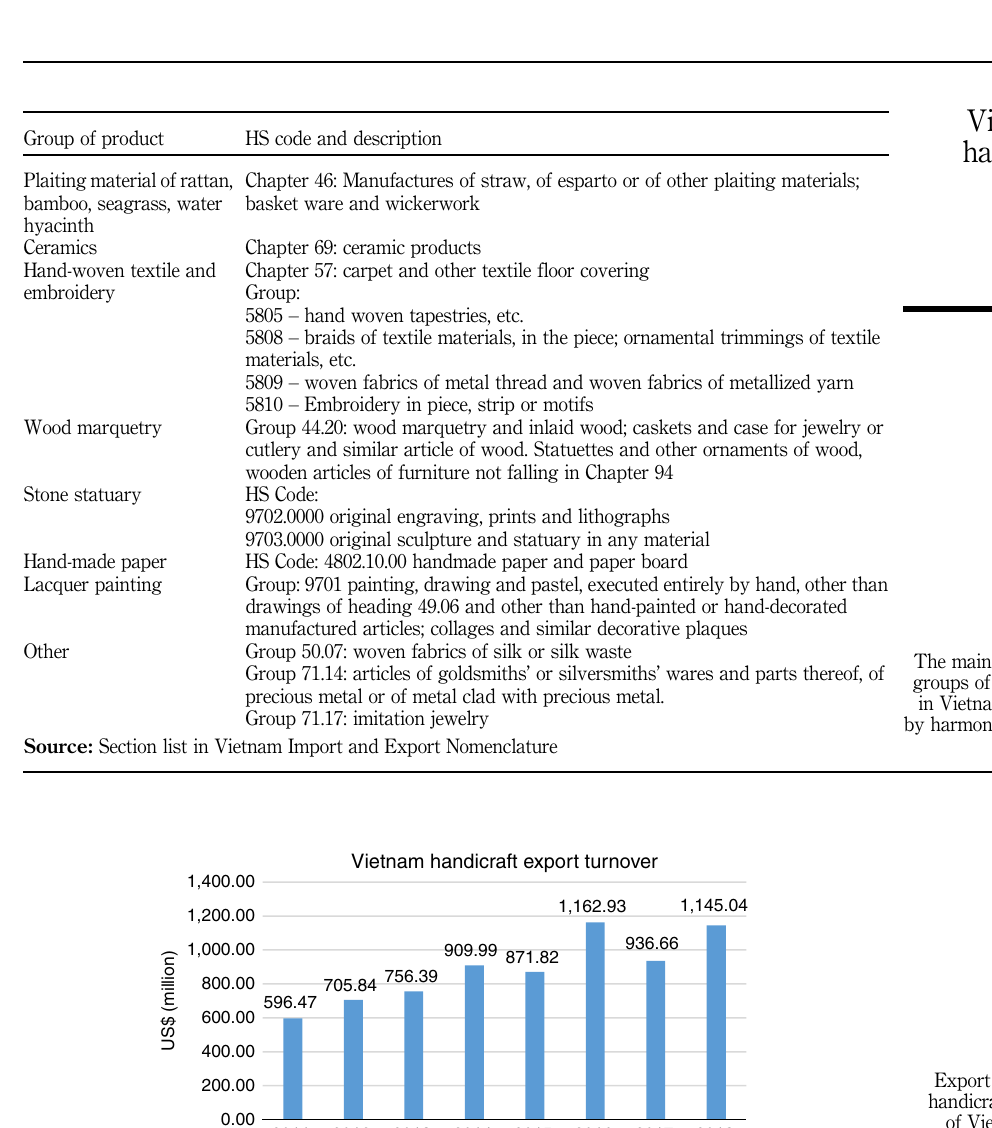
Figure 1. Export turnover